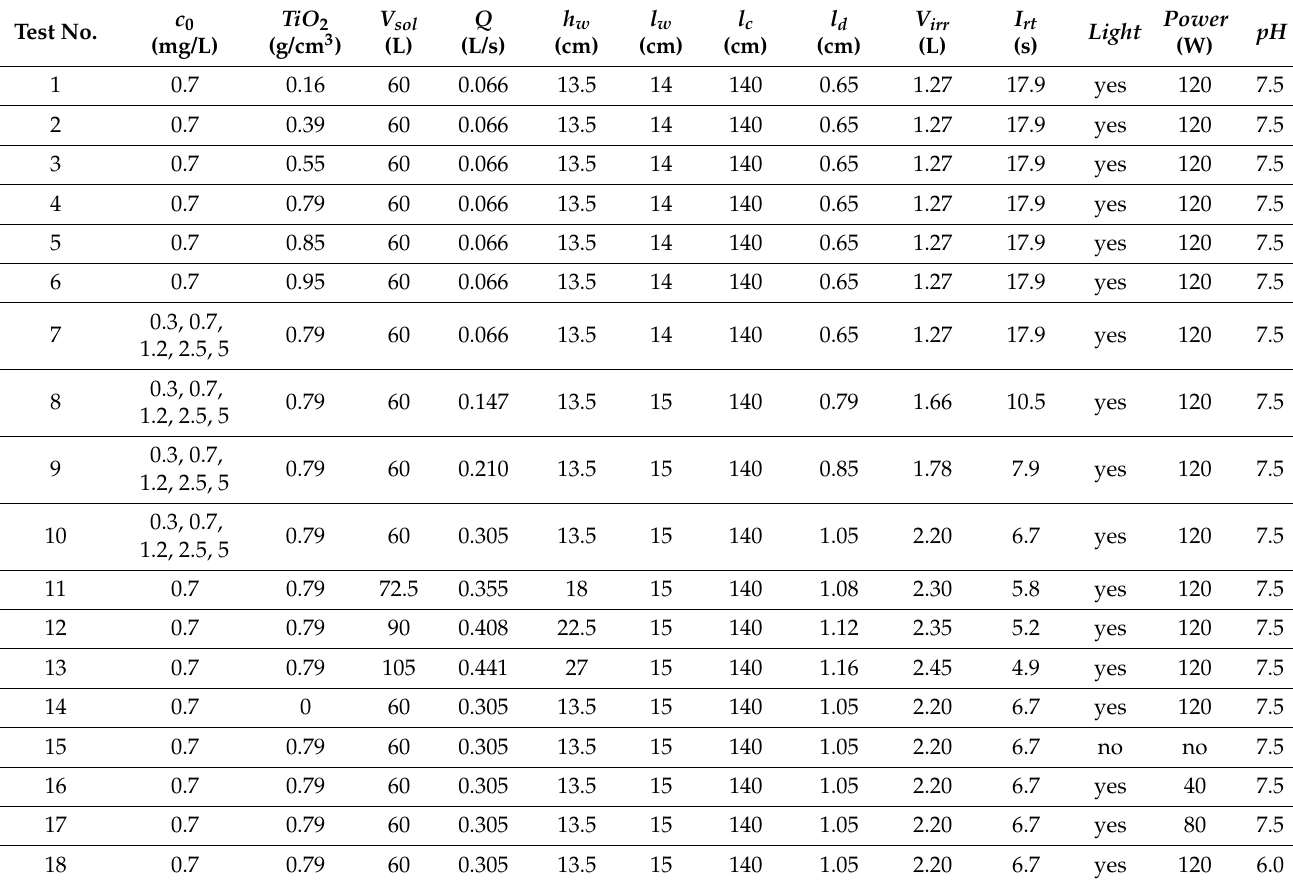
Table 1. Summary of the tests carried out in the present investigation. c 0 = initial dye concentration, V sol = volume of the influent solution, Q = flow-rate, h w = hydraulic load, l w = irradiated liquid width in the channel, l c = irradiated liquid length in the channel, l d = irradiated liquid depth in the channel, V irr = irradiated volume ( l w × l c × l d ) of the liquid in the channel, I rt = irradiated retention time ( V irr /Q ), irradiation power (W), pH . Test